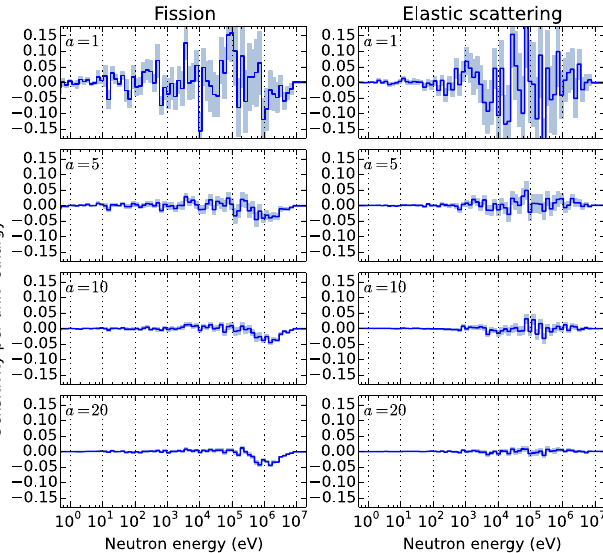
Fig. 4. Comparisons of b eff sensitivity pro fi le of 239 Pu fi ssion (left) and elastic scattering (right) cross sections for the critical core with different scaling factors. The pale blue color around the blue line indicates 1 s statistical